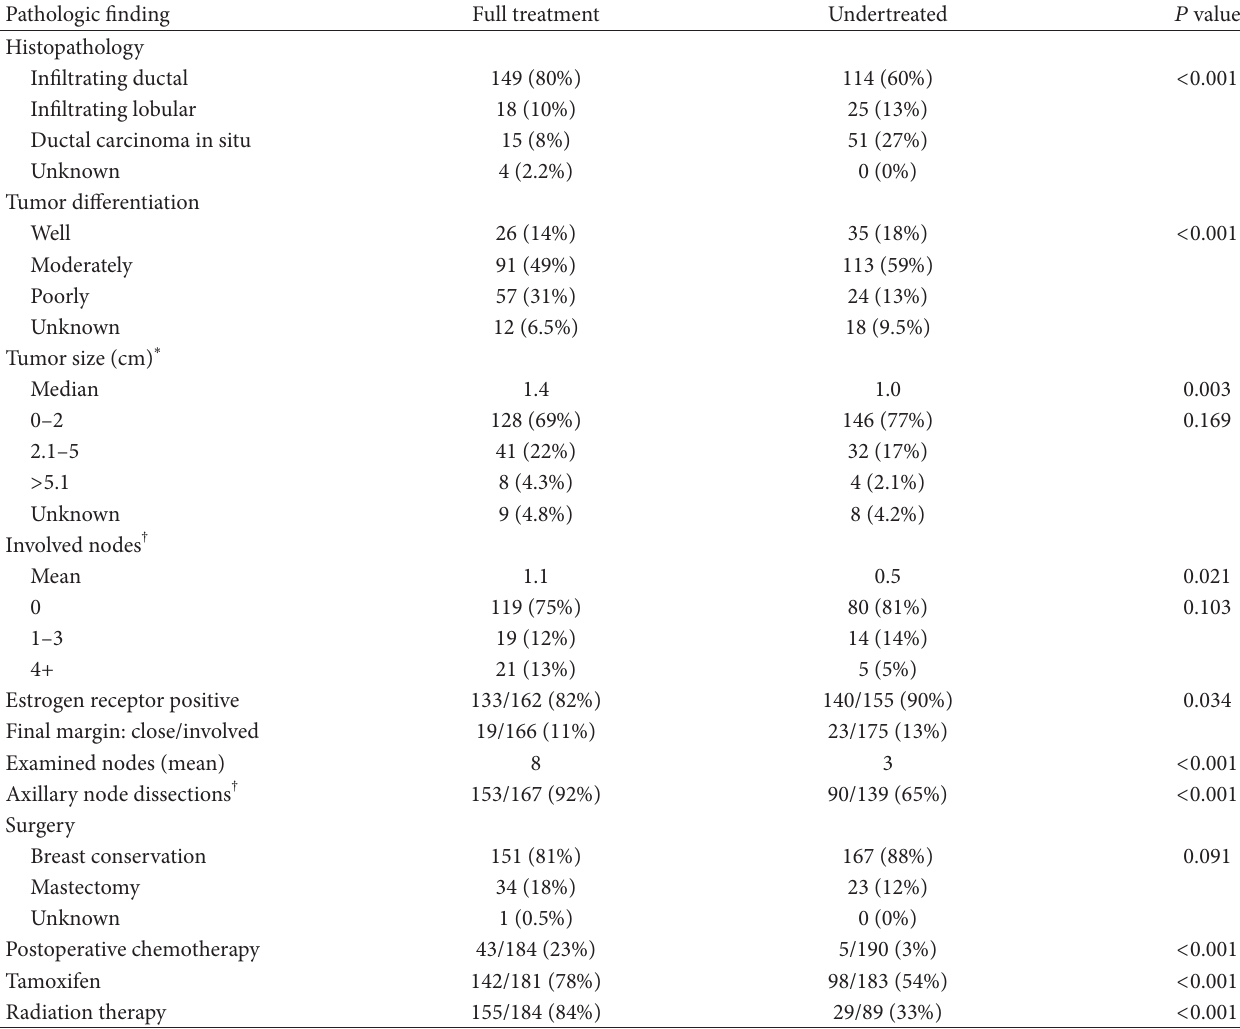
T 4: pathologic �ndings in undertreated and properly treated